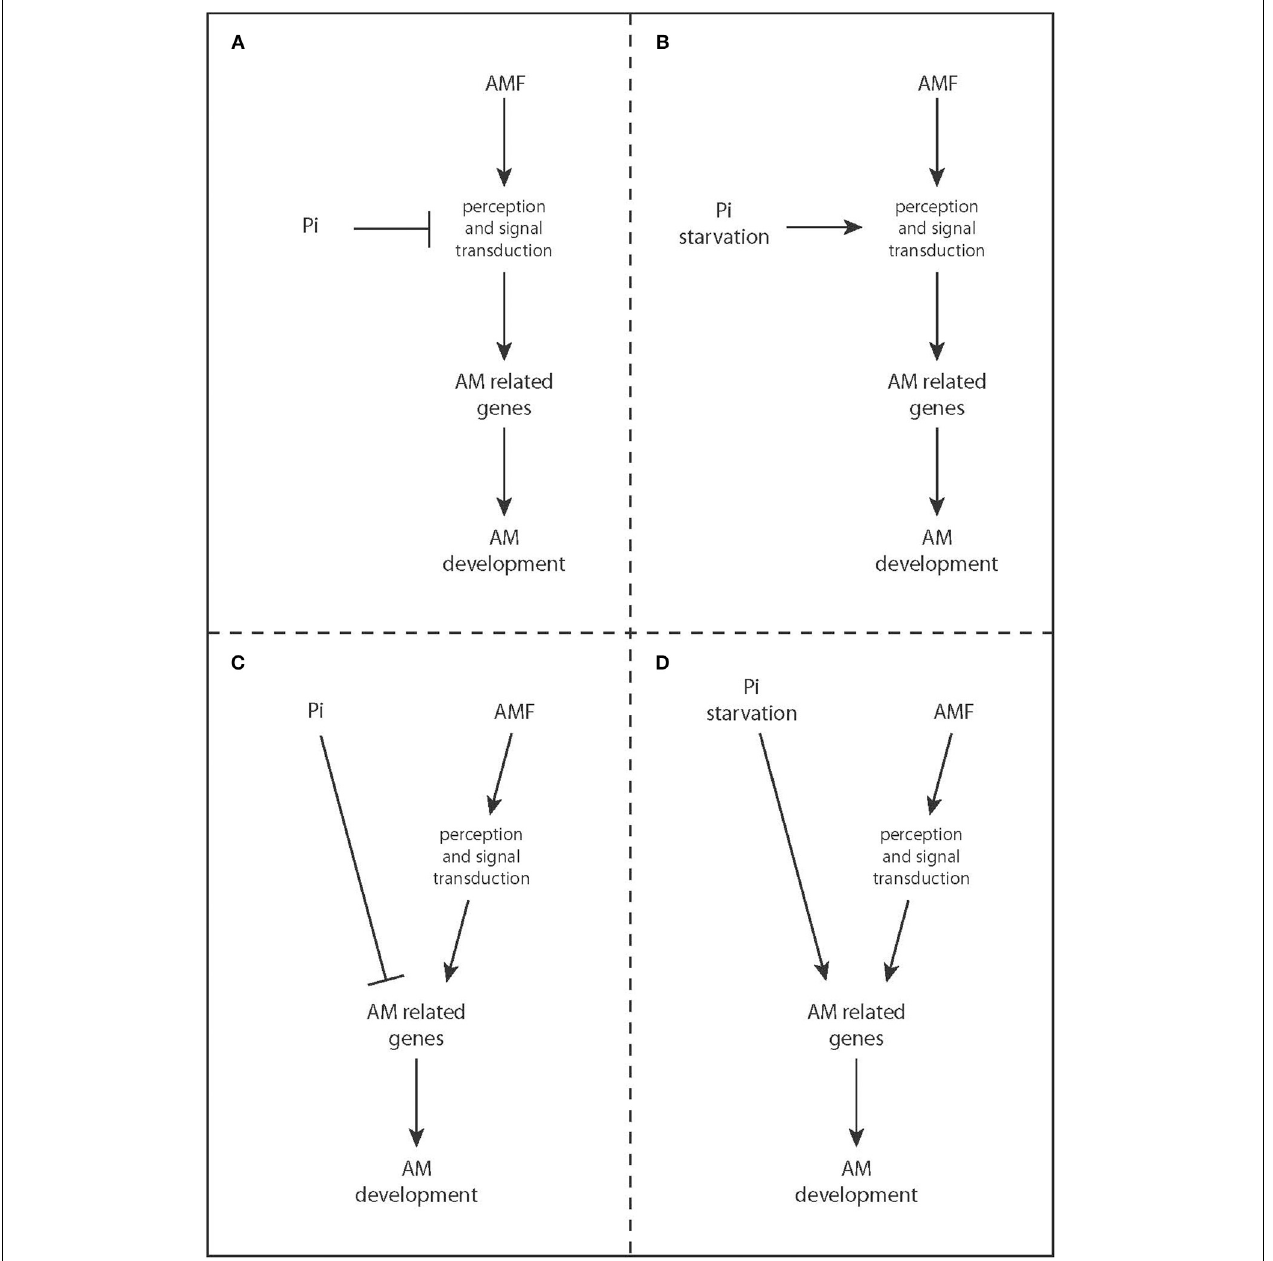
FIGURE 1 | Hypothetical models of how phosphate signaling might control AM development. Other nutrients might influence AM development in a similar fashion as shown here for P i . (A,B) Perception of Myc factors, signal transduction through common SYM network or other symbiosis signaling pathways are directly targeted by P i signaling. (C,D) P i and